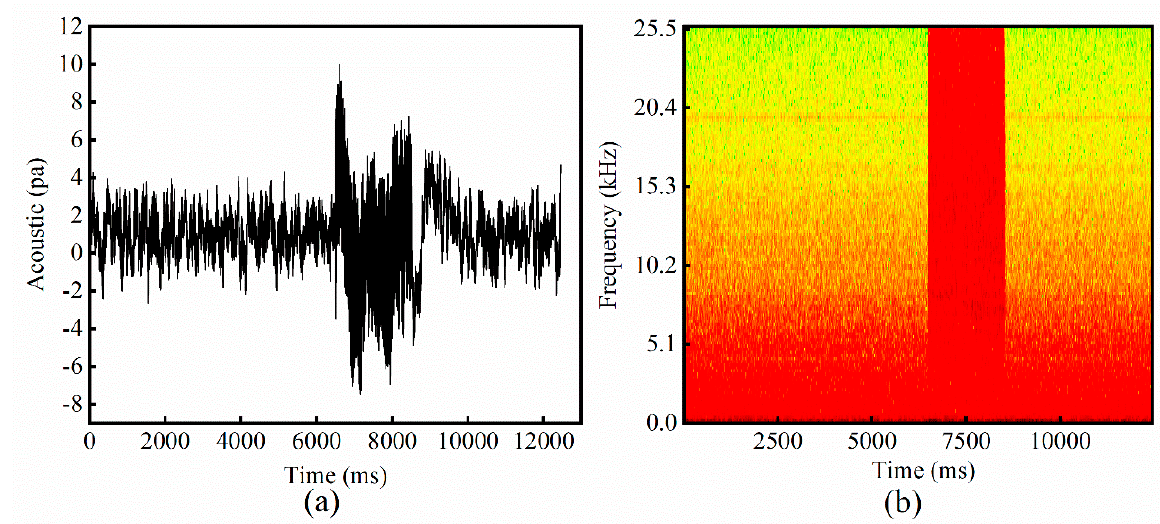
Figure 7. The STFT of sound signal during SLM: ( a ) Time-domain diagram of the sound signal (The red box illustrates the window function), and ( b ) the time-frequency diagram after STFT transformation. (scanning speed 30 mm/s and laser power 200 W).